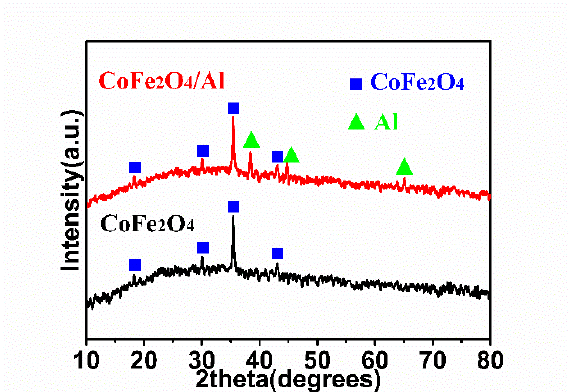
Figure 2. The XRD patterns of the CoFe 2 O 4 nanowires (NWs) film and the CoFe 2 O 4 /Al NWs nanothermite film.